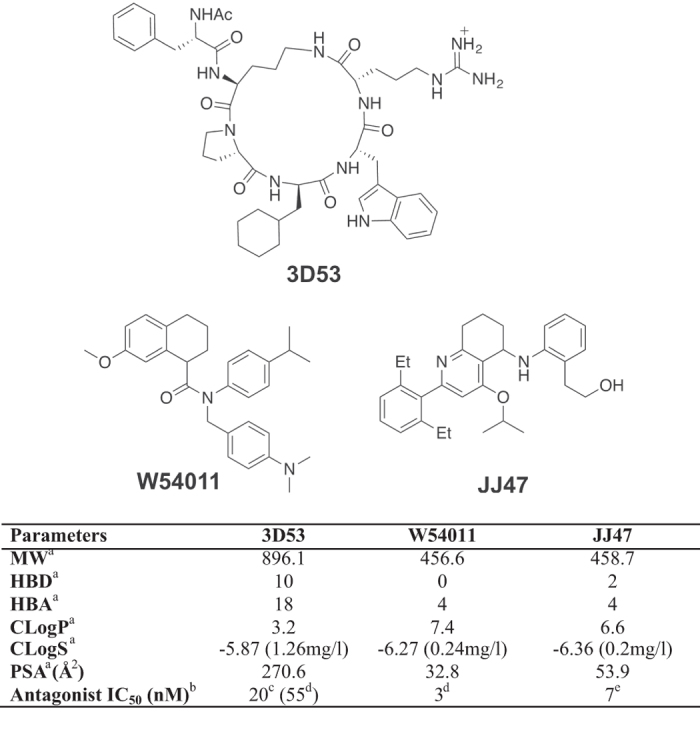
Comparative properties and in vitro potencies of C5aR antagonists.Top: Chemical structures for antagonists 3D53, W54011 and JJ47. Bottom: Properties and antagonist potencies of the three compounds. aMW = molecular weight, HBD = hydrogen bond donors, HBA = hydrogen bond acceptors, ClogP = calculated octanol-water partition coefficient, CLogS = calculated aqueous solubility, PSA = Polar surface area. bInhibition of Ca2+ release in different cells, under different conditions and against different concentrations of C5a. cVersus 100 nM rhC5a on neutrophils12. dVersus 0.1nM rhC5a on neutrophils14. eVersus 1.5 nM rhC5a on U937 cells15.